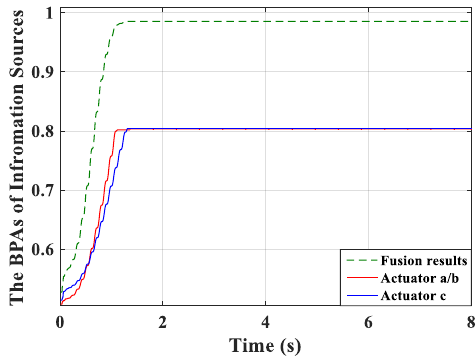
Figure 8. The basic probability assignment (BPA) curves.